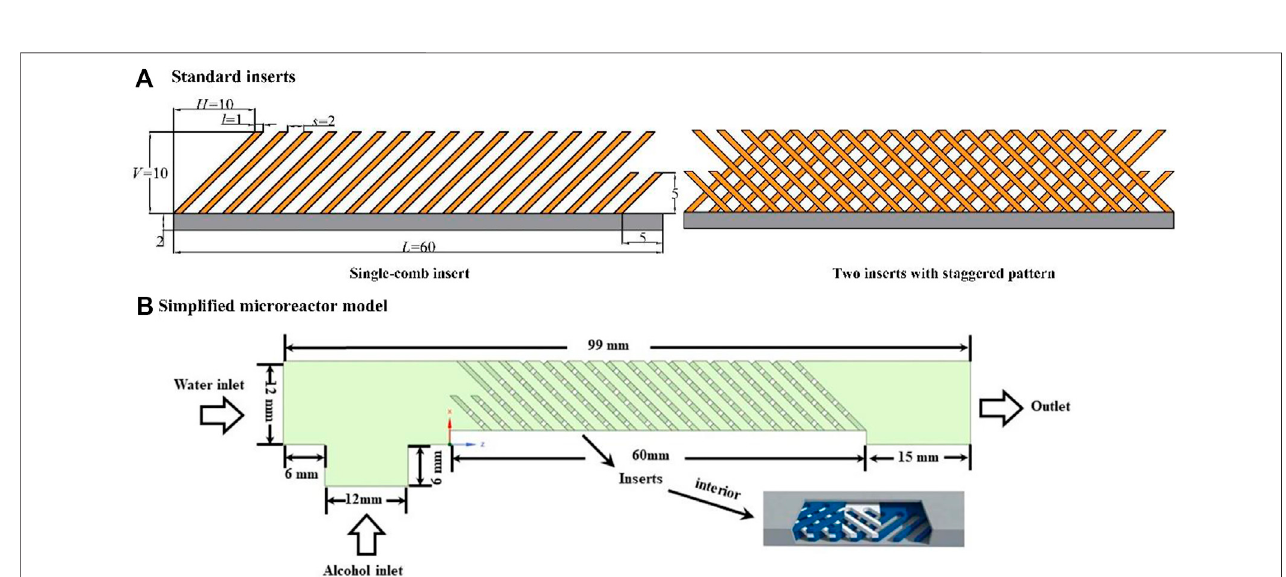
FIGURE 2 | Schematic diagram of standard inserts [ (A) , s / l (cid:1) 2, V / H (cid:1) 10:10] and (B) a simpli fi ed microreactor model.